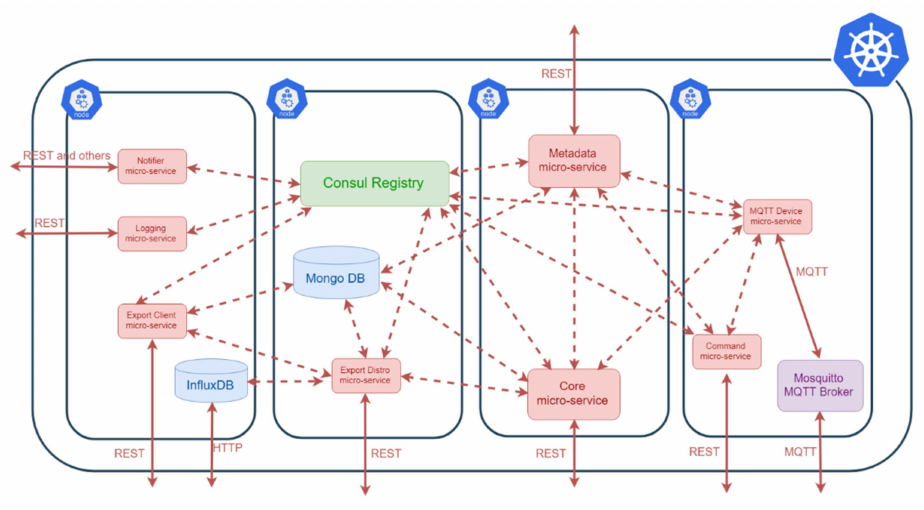
Figure A4. Edge X Foundry microservice